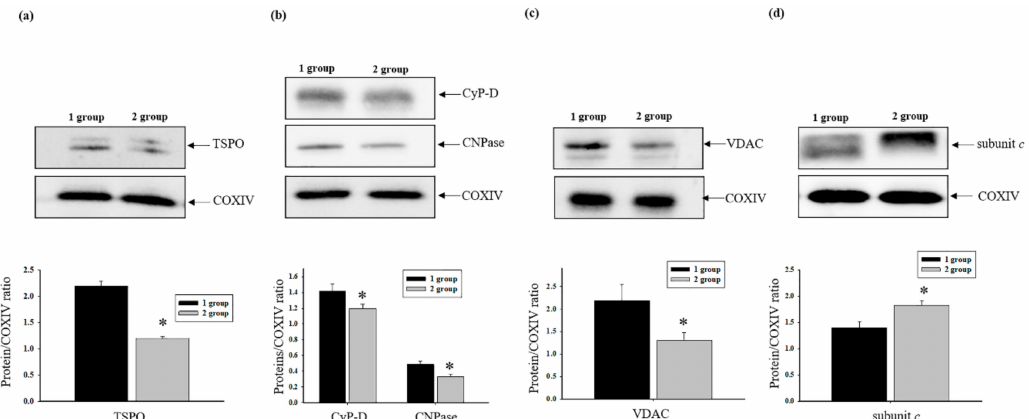
Figure 4. The e ff ect of AST administration on mitochondrial protein content: cyclophilin D (CyP-D), translocator protein (TSPO), 2 (cid:48) , 3 (cid:48) -cyclic nucleotide 3 (cid:48) -phosphodiesterase (CNPase), subunit c , and voltage-dependent anion channel (VDAC) in intact RHM from each group of rats. Antibody to cytochrome c oxidase subunit IV (COX IV) was used as loading control. ( a–d ) Upper parts: Western blots stained with corresponding antibodies; (lower parts): diagrams quantitatively reflecting changes in protein content in absolute units normalized to COX IV. Data are presented as means ± SDs of five independent experiments. * p < 0.05—significant di ff erence in protein level compared with control (RHM isolated from first group of